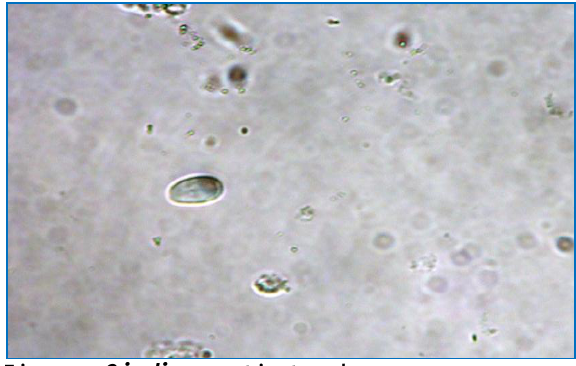
Figure, g: Giardia sp. cyst in stray dogs. Table, 2: Prevalence of intestinal parasites and protozoa during months of study.